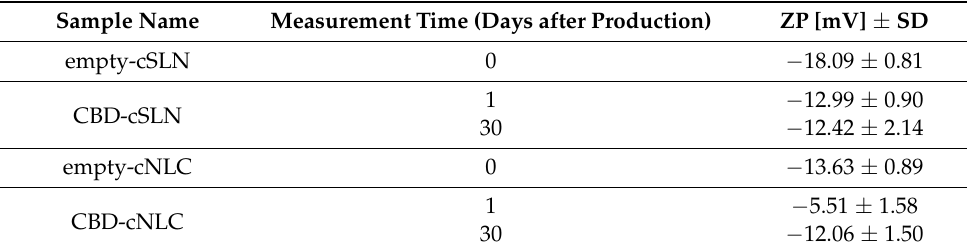
Table 2. ZP for CBD-cSLN and CBD-cNLC on the 1 and 30 days after the production.